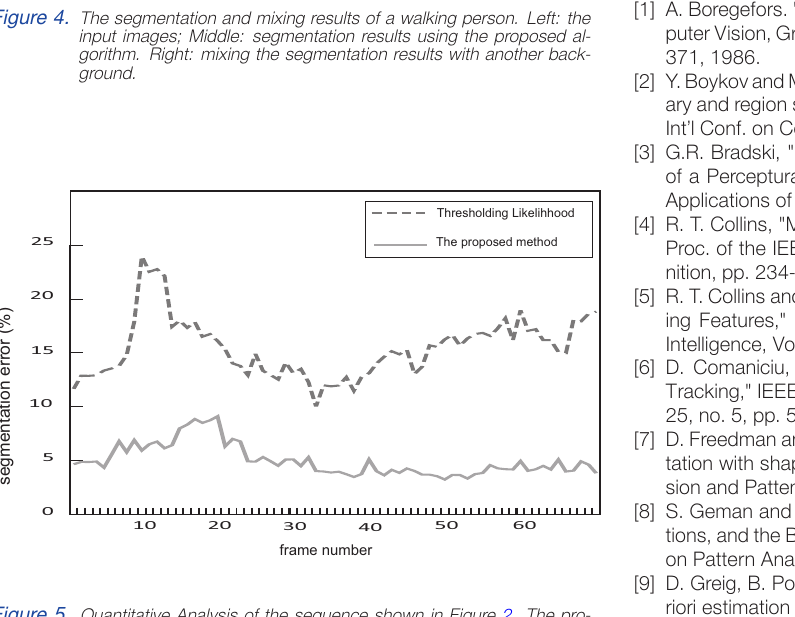
Figure 5. Quantitative Analysis of the sequence shown in Figure 2. The pro- posed method has better performance than other approach in most of the